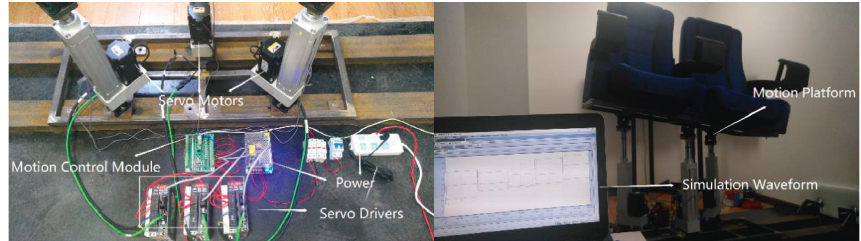
Figure 18: Physical model of the motion control platform of the dynamic seat.